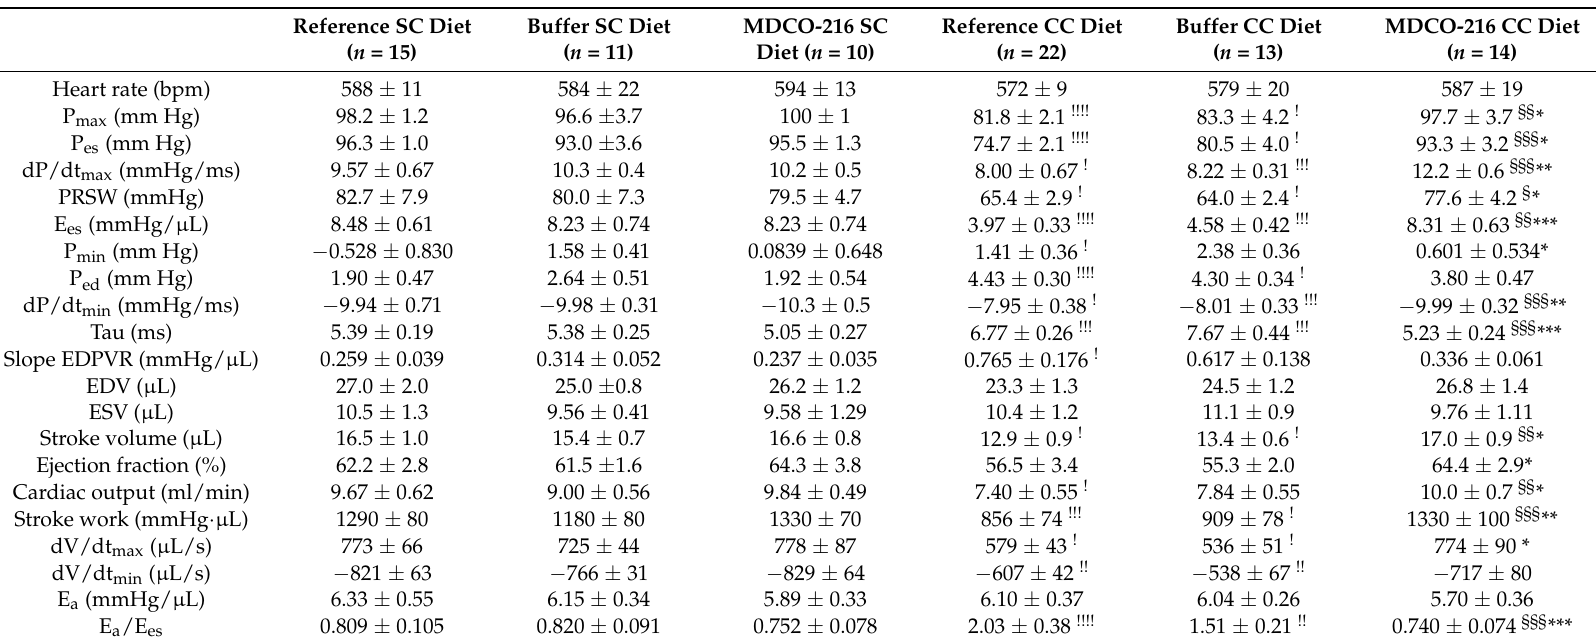
Table 3. Overview of hemodynamic data in C57BL/6 mice and in intervention C57BL/6 mice fed standard